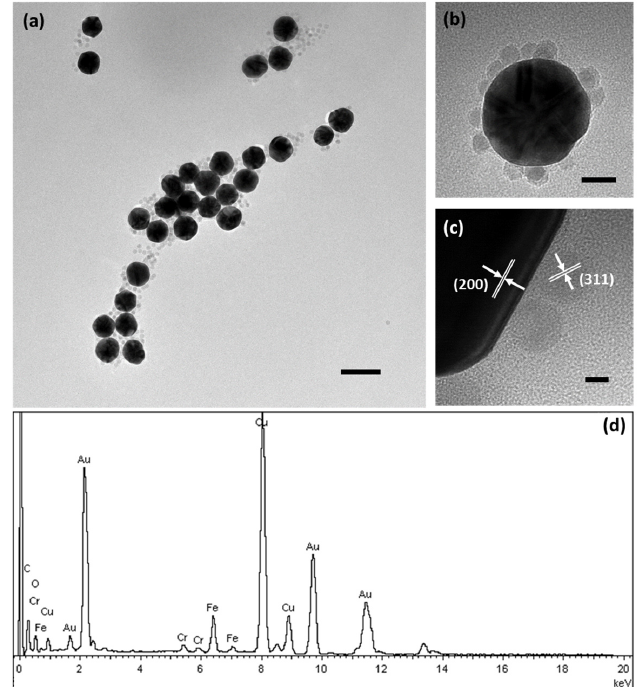
Figure 1. ( a ) TEM image of Au-Fe 3 O 4 nanocomposites; ( b ) TEM image of a single Au-Fe 3 O 4 nanocomposite; ( c ) HRTEM image of a part of a single nanocomposite. The scale bars are 100 nm, 20 nm and 5 nm in ( a – c ), respectively. ( d ) Energy-dispersive spectrum of Au-Fe 3 O 4 nanocomposites.